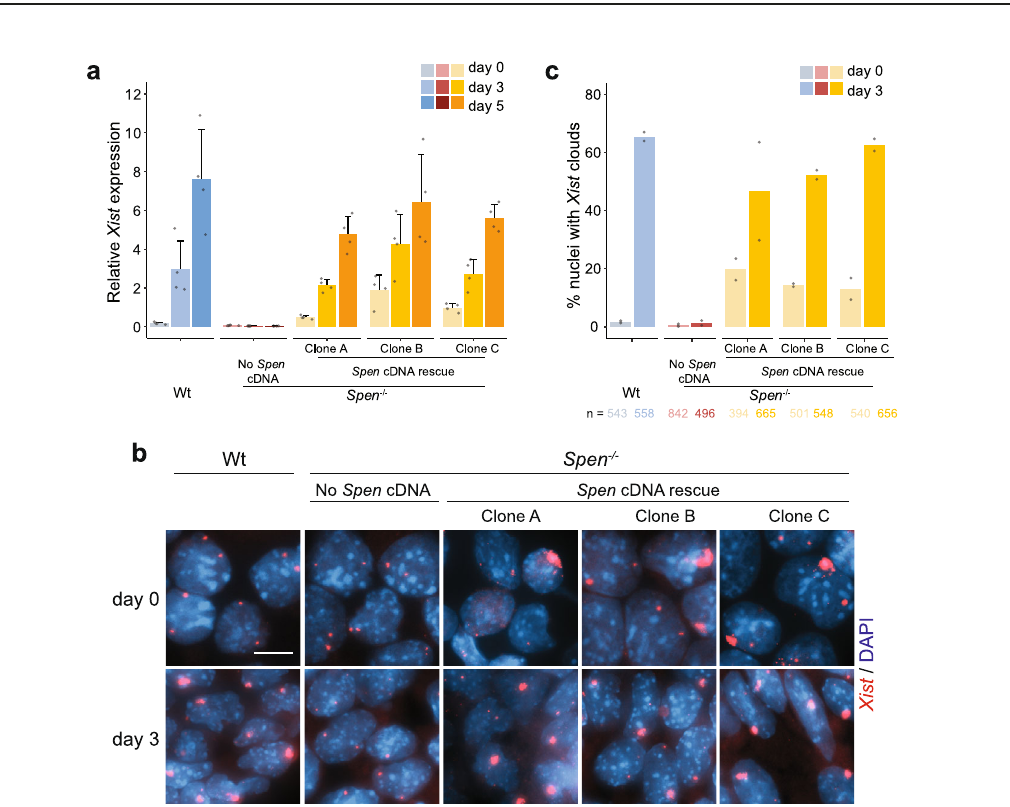
Fig. 1 Impaired Xist upregulation in Spen − / − ESCs upon monolayer differentiation. a Overview of the endogenous doxycycline-inducible Xist hybrid system used in this study. Addition of doxycycline leads to inactivation of the Cast X chromosome, while no addition of the drug leads to inactivation of the 129 X chromosome. b Violin plots depicting the distribution of the allelic ratios ((Xi)/(Xi + Xa)) of X-linked genes in Wt and Spen − / − ESCs, untreated or treated with doxycycline at days 0, 3, and 7 of differentiation. This fi gure summarizes data in Supplementary Fig. 1e. The box plots inside the violin plots display the median (central white dot), the interquartile range (box limits) and the whiskers represent 1.5x of the interquartile range. Two-sided Mann – Whitney test corrected with Benjamini – Hochberg for multiple testing ( α < 0.05). n = genes with more than 20 reads. Xa = active X chromosome. c Percentage of Rnf12 allelic expression at different time points of monolayer differentiation of two independent Wt and Spen − / − ESC lines treated with doxycycline, determined by RT-qPCR. Relative Rnf12 allelic (129 and Cast) expression was normalized to Rnf12 total expression and averaged ± standard deviation (SD). Reference gene: Hist2h2aa1 . d Relative allele-speci fi c Xist expression of two independent Wt and Spen − / − ESC lines at different time points of monolayer differentiation treated with doxycycline. Average expression ± SD. Reference gene: Hist2h2aa1 . e Same as displayed in ( c ) without doxycycline. f Same as displayed in ( d ) without doxycycline. g Xist RNA FISH (red) of Wt and Spen − / − ESC lines at days 3 and 5 of differentiation. Both Tsix pinpoints (arrowheads) and Xist clouds (asterisks) are visible. DNA is stained with DAPI (blue). Scale bar: 10 µ m. h Quanti fi cation of ( g ), displaying the average percentage of nuclei with Xist clouds. Average percentage ± SD, the total number of counted nuclei per clone is indicated. i Relative allele-speci fi c Tsix expression of Wt and Spen − / − ESCs at different time points of monolayer differentiation, determined by RT-qPCR. Average expression ± SD. Two- sided Mann – Whitney test ( α < 0.05). Reference gene: Hist2h2aa1 . ( c – f, h, i ) n = 4 biological replicates including 2 independent clones (squares vs. circles) per condition.